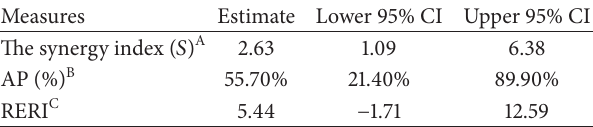
Table 4: Measures from the departure-from-additivity model